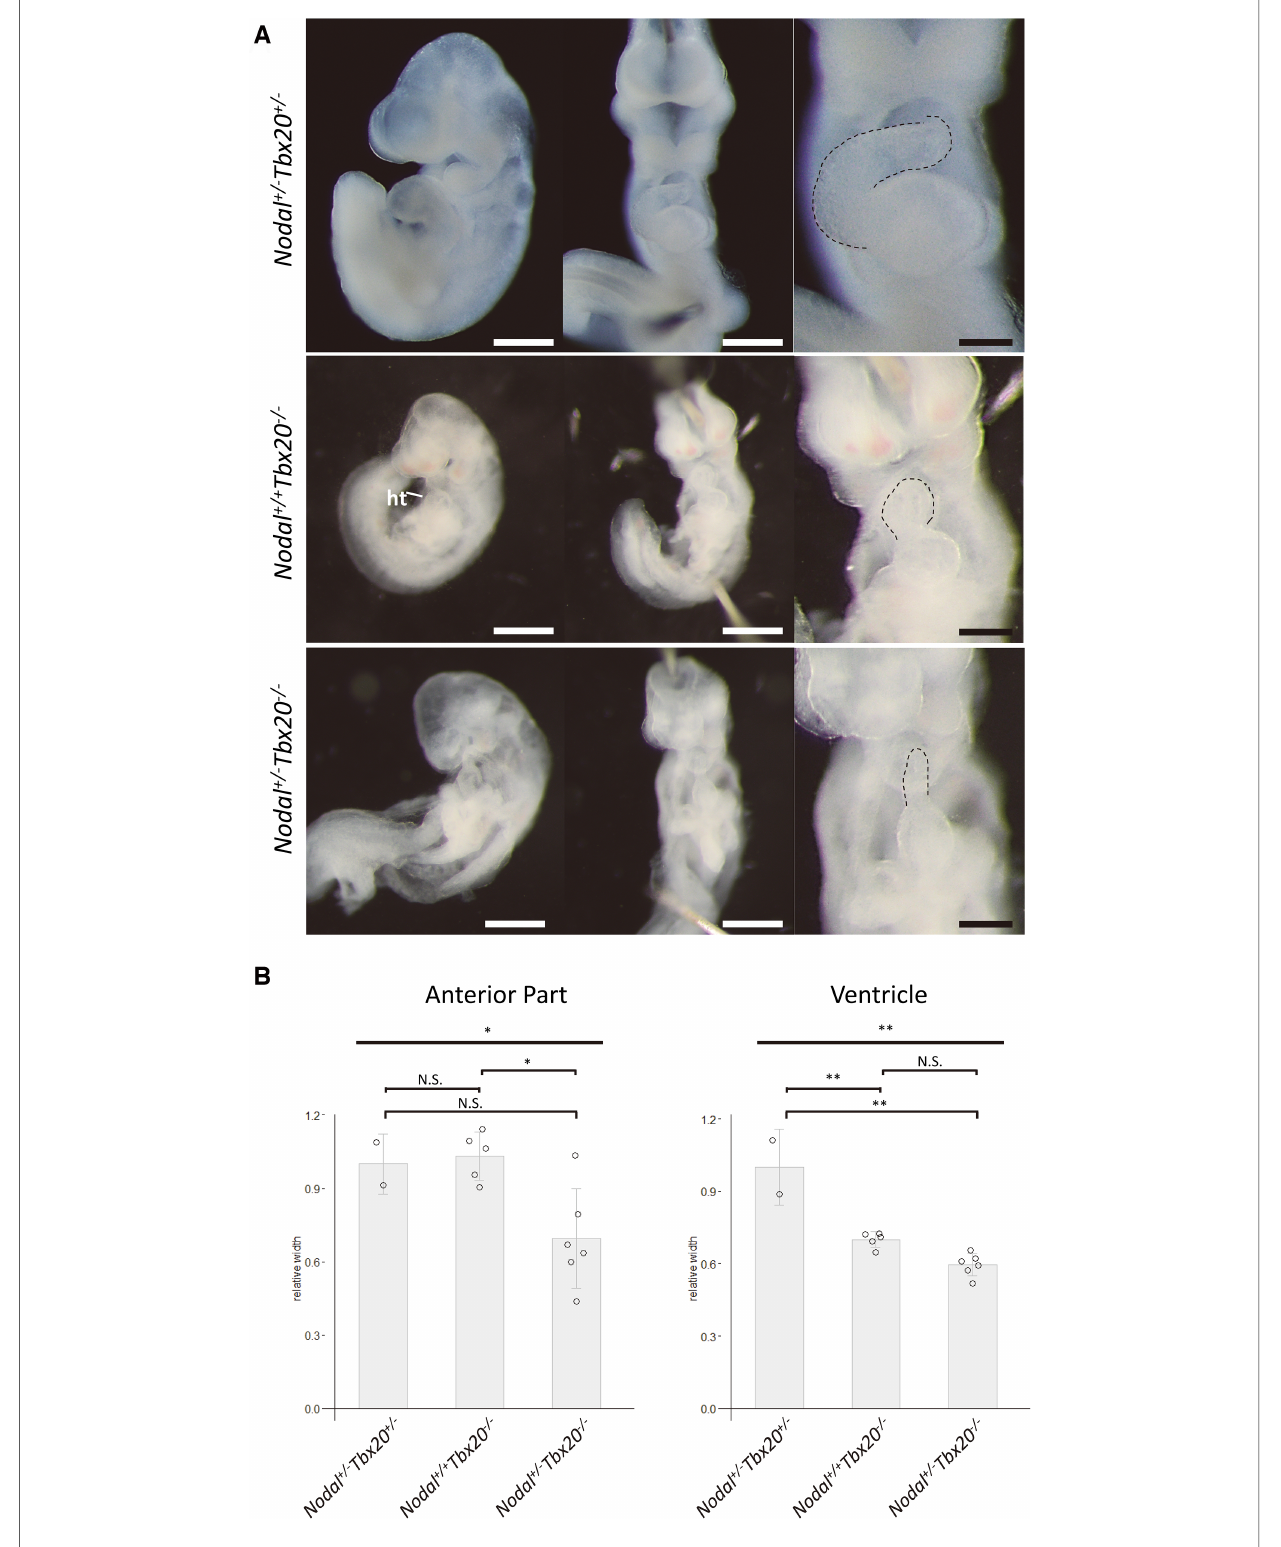
FIGURE 4 Hypoplasia of anterior part in NODAL heterozygous TBX20 homozygous heart. ( A ) Left lateral views and frontal views of Nodal +/+ Tbx20 − / − and Nodal +/ − Tbx20 − / − hearts at embryonic day 9.5. Dotted lines show the anterior parts of the heart tubes. ht, heart. Scale bars, 500 µm in left and middle panels and 200 µm in right panels. ( B ) Bar graphs showing the widths of the anterior or the ventricular part of the hearts. The signi fi cant decrease in the width of the anterior parts in Nodal +/ − Tbx20 − / − hearts. All values are expressed as the mean±SD. Signi fi cance was assessed using one-way ANOVA, followed by Tukey ’ s post hoc test. *, p <0.05; **, p <0.01; N.S., not signi fi